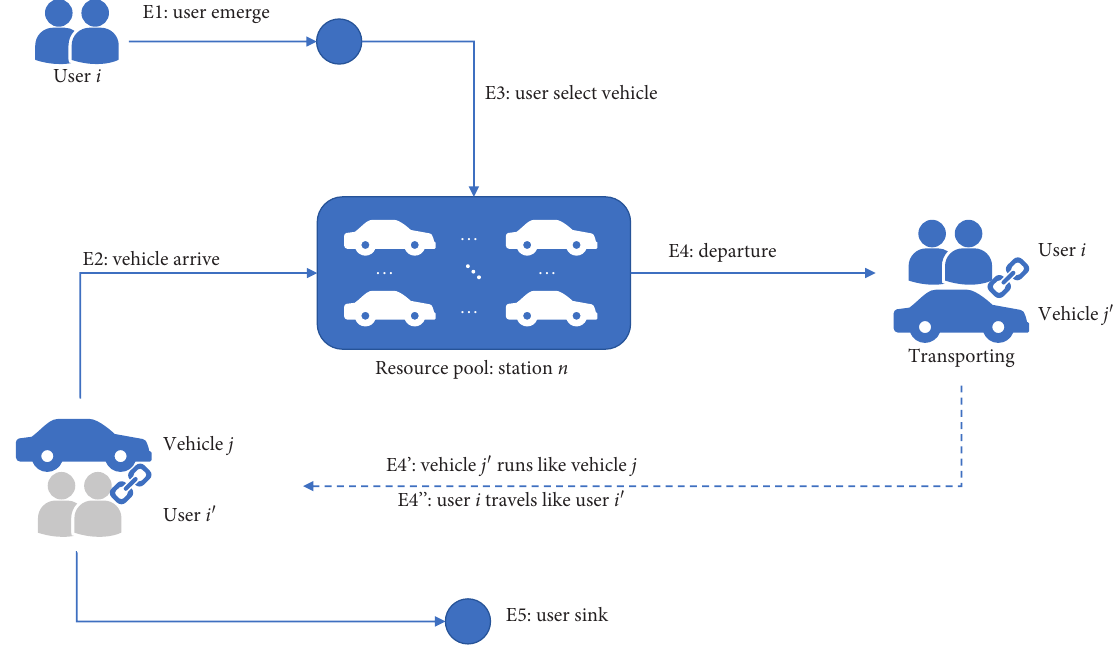
Figure 4: Events in instant access